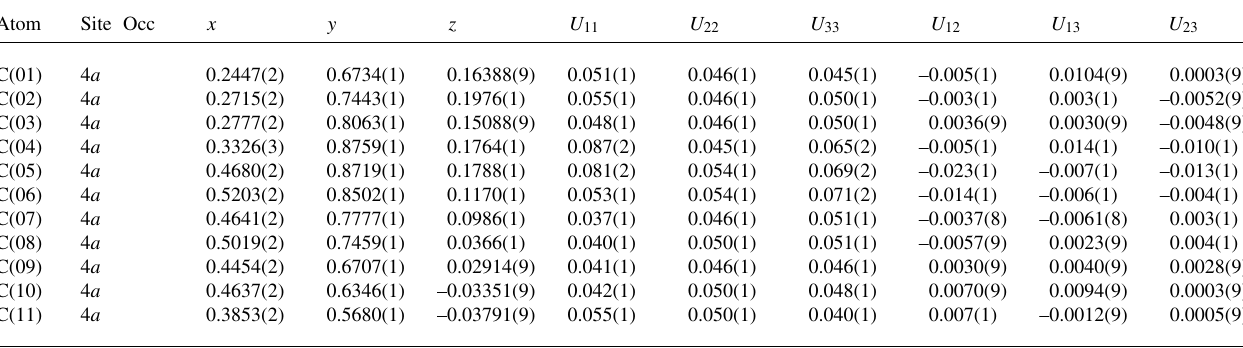
Table 3. Atomic coordinates and displacement parameters (in Å 2 )